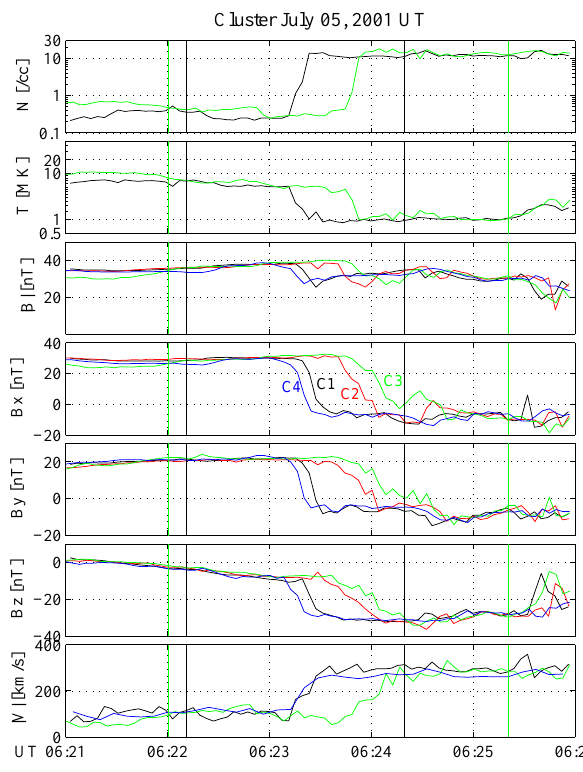
Fig. 8. Time plots of Cluster measurements around a magnetopause crossing event occurring at ( − 6.78, − 14.97, 6.24) R E in GSE on 5 July 2001. The format is the same as in Fig.